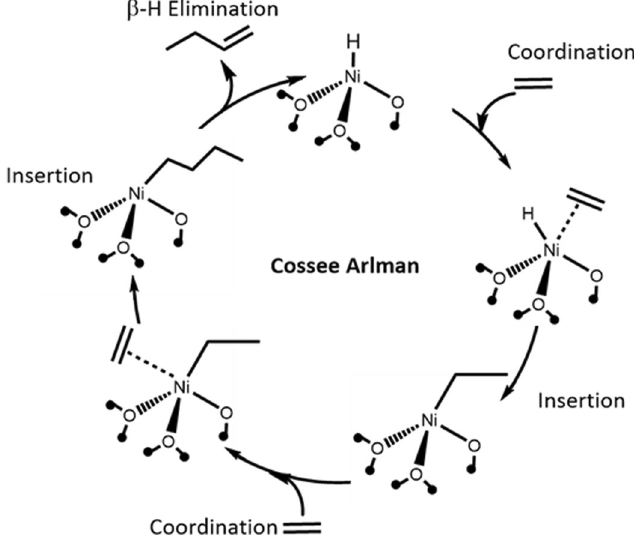
Fig. 1 Cossee – Arlman Ni oligomerization mechanism. Elementary reaction steps and intermediates 68